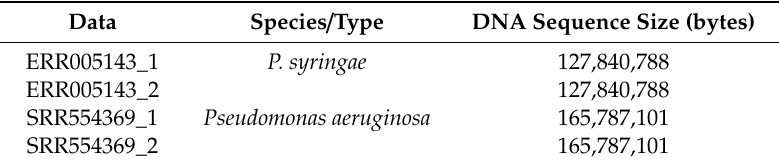
Table 3. A selected DNA-FASTQ